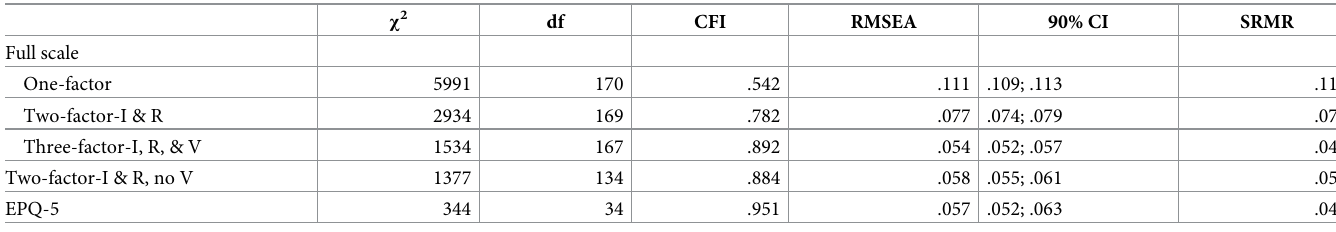
Table 2. Confirmatory factor analyses for Study